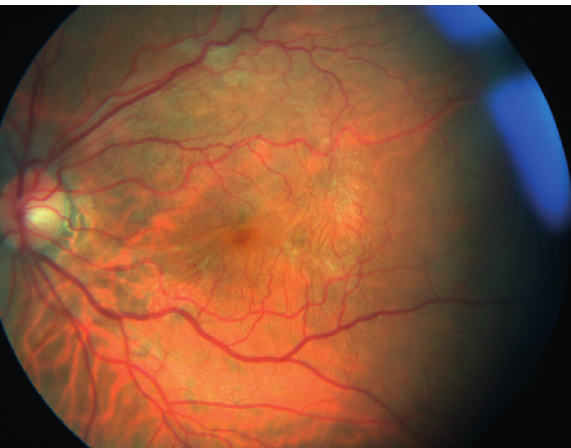
Fig. 2. Improvement of the state without treatment.